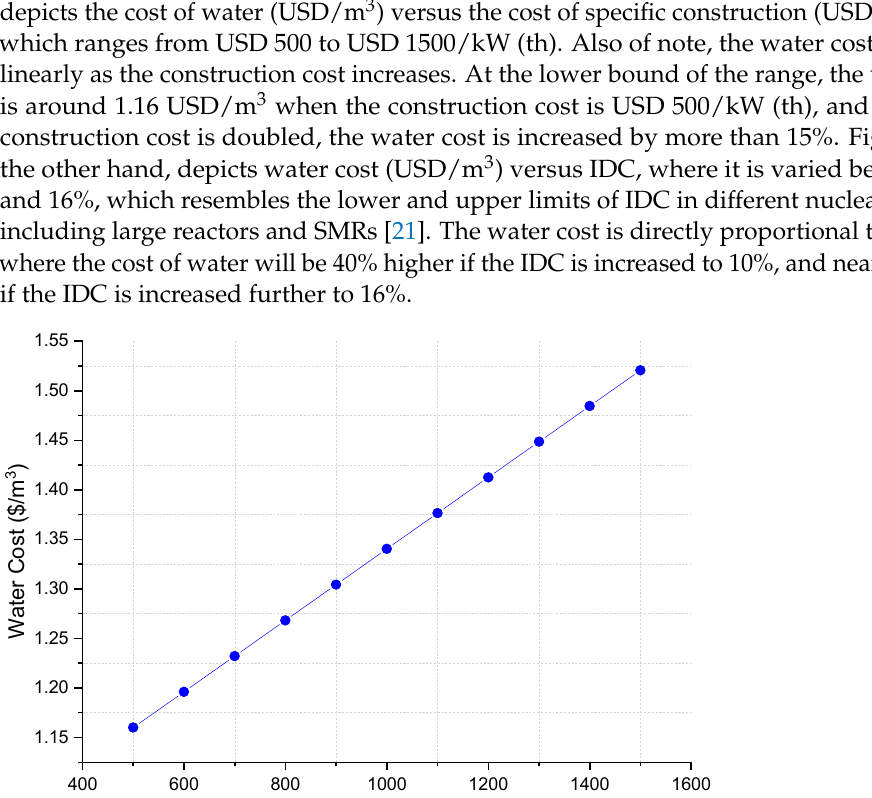
Figure 6. Sensitivity analysis of water cost (USD/m 3 ) versus specific construction cost (USD/kW (th)) of the nuclear heating reactor.